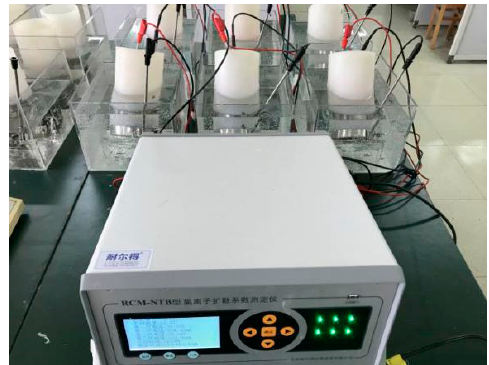
Figure 6. RCM test setup.